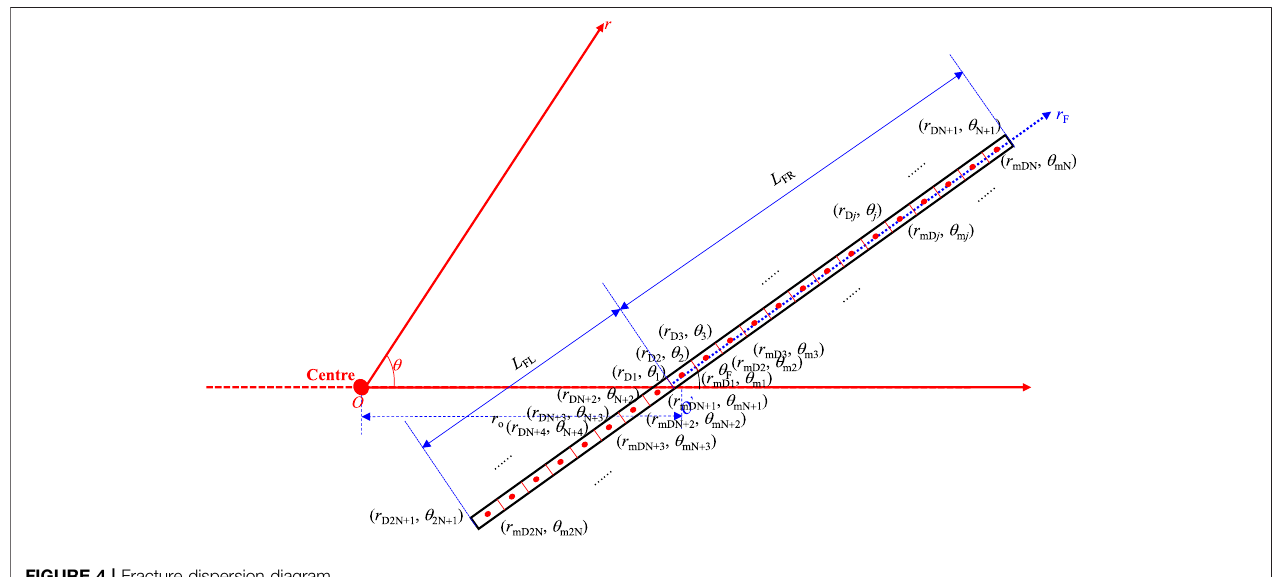
FIGURE 4 | Fracture dispersion